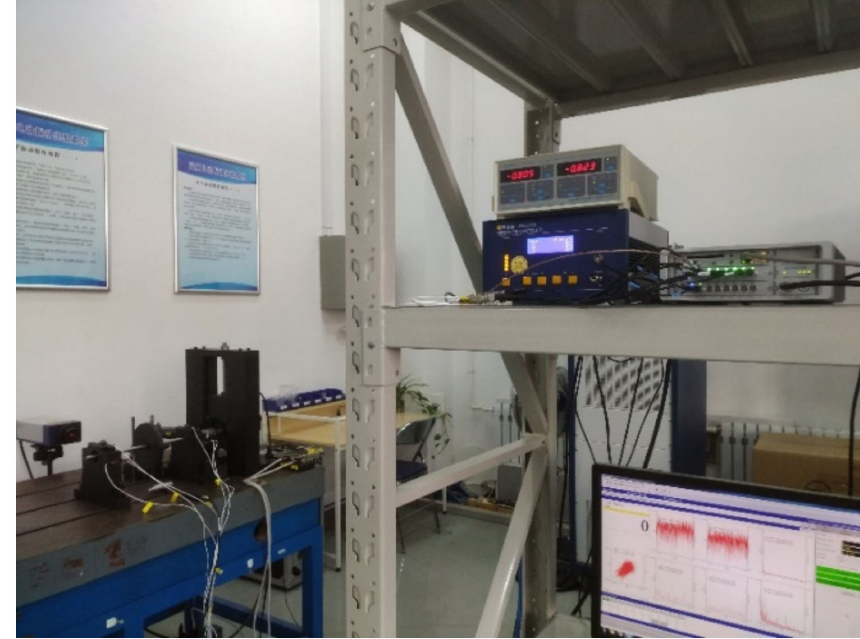
Figure 12. Experimental system of an asymmetric